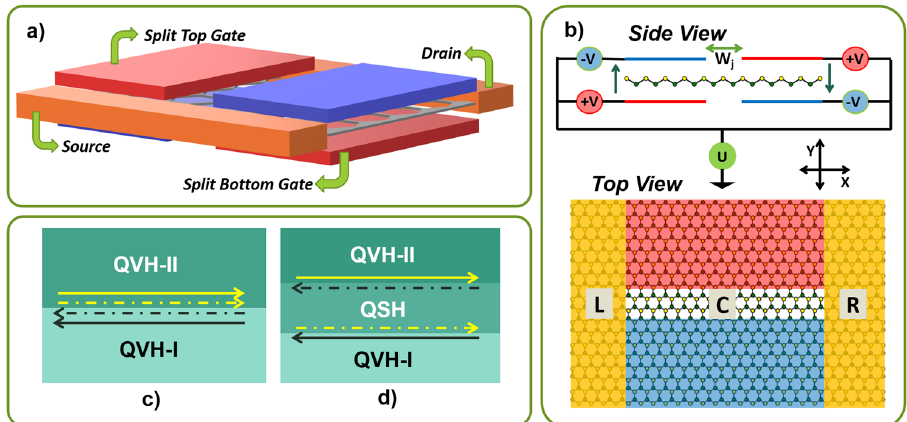
Fig. 1 Device schematics and operation. a Proposed dual split-gated device structure with a monolayer 2D-Xene nanoribbon of buckling height 2 l sandwiched between the gates. b Side and top view of the valley fi lter device. The left lead, the right lead and the channel region are denoted by L , R , and C respectively. Sublattice A sites are marked in yellow and sublattice B sites in green. c Valley-momentum locked conducting channels hosted at the domain wall between QVH phases with reversed inversion asymmetry. d Spin – valley-momentum locked conducting channels hosted at the spatially separated domain walls between the QSH and the QVH phases.